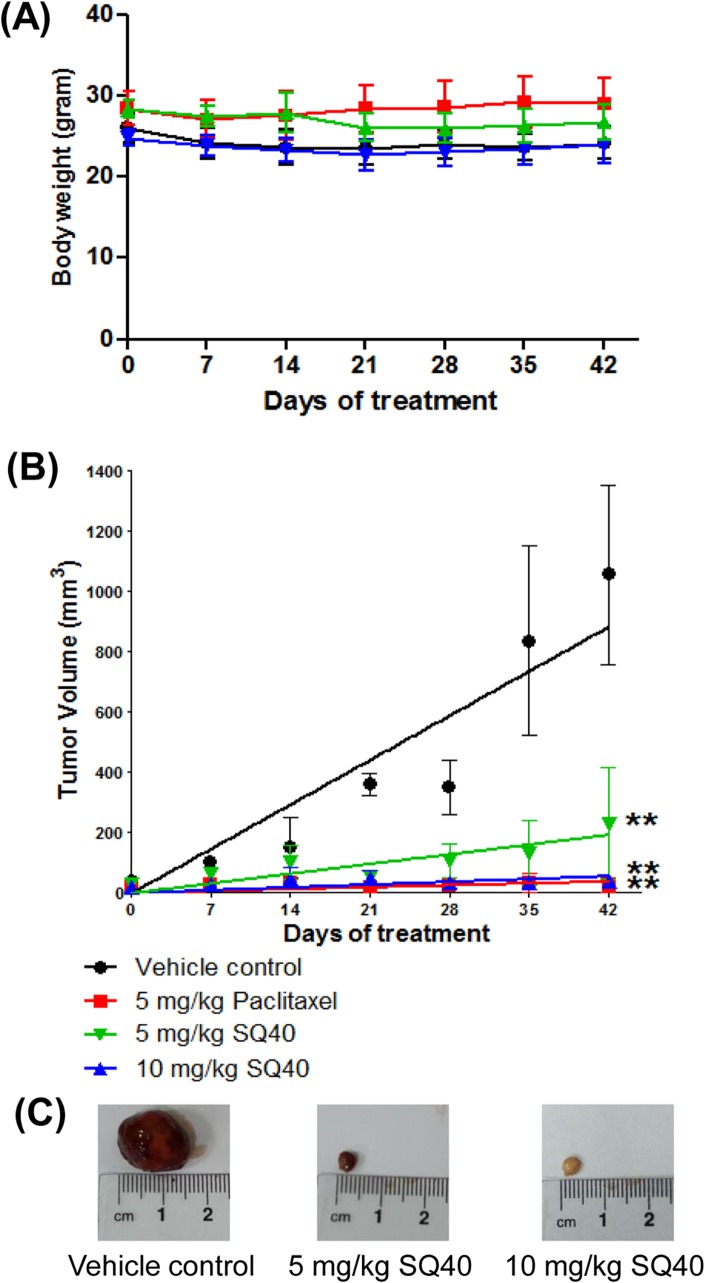
Anti-tumor activity of SQ40 against subcutaneous LNCaP cell tumors.LNCaP cells at 2 x 106 were injected subcutaneously into right flank of NCr nude mice. SQ40 treatment was initiated when the tumor was palpable. Vehicle control (saline) and SQ40 were given intraperitoneally thrice a week for 6 weeks with a total of 18 doses. Graph of (A) mean body weight and (B) tumor volume for each treatment versus the number of days after initial injection of LNCaP cells. (C) Representative images of tumors isolated from vehicle control, 5 mg/kg and 10 mg/kg of SQ40-treated animals. Each point represents the mean ± SEM of data (n = 6). ** indicates p<0.01 versus vehicle control.